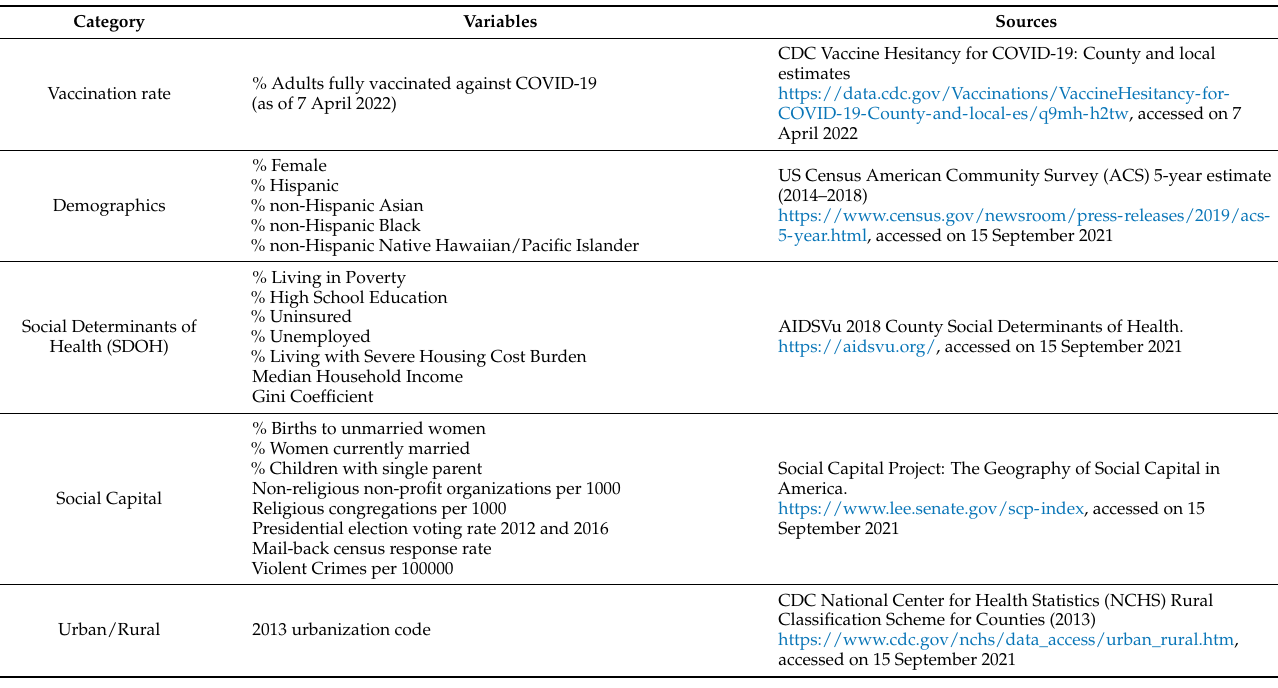
Table A1. Selected variables and data sources.